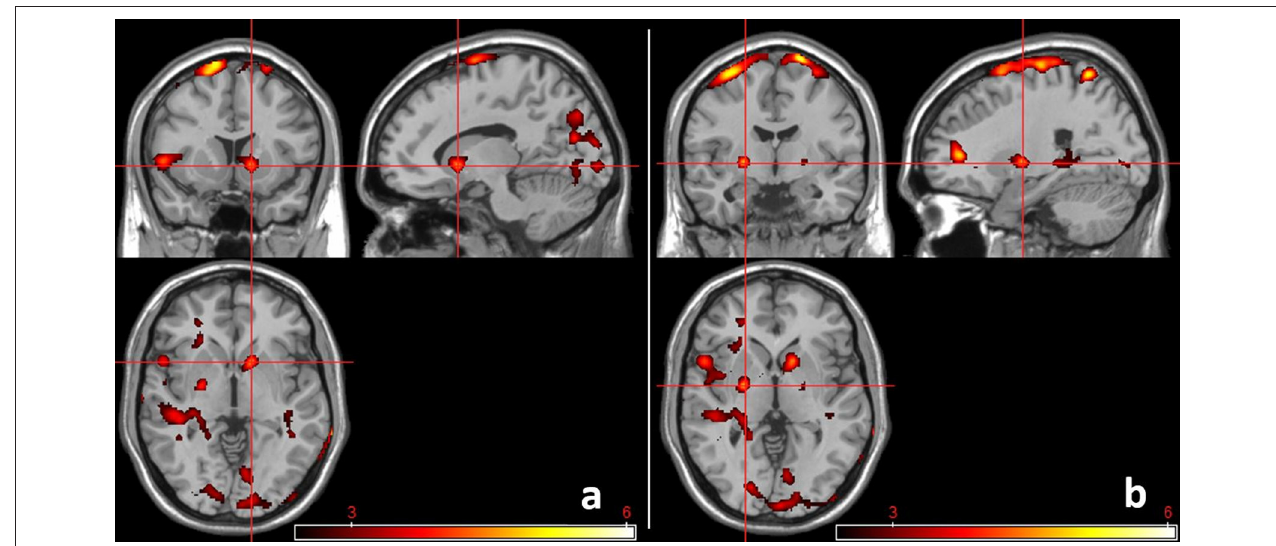
FIGURE 5 | Brain activation during action withholding in positive relation to commission errors. All individuals were included in the regression analyses. Activation within motor regions and subcortical regions became apparent. (a) Activation within right subcortical regions (12, 12, − 2). (b) Activation within left subcortical regions ( − 24, − 6, 0). CDT of P < 0.01 ( k ≥ 460). The color bar indicates t-scores, with red to yellow indicating a positive